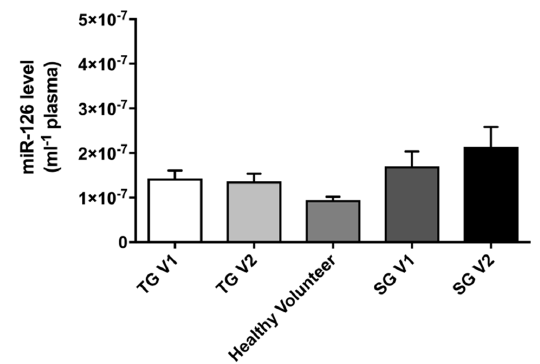
Figure 5. A comparison of the plasma levels of miR-126 (per mL) in all groups. The results are presented as the mean ± SEM. Treatment group pre-metformin (TG V1), treatment group post-metformin (TG V2), standard group pre-observation (SG V1) and standard group post-observation (SG V2).